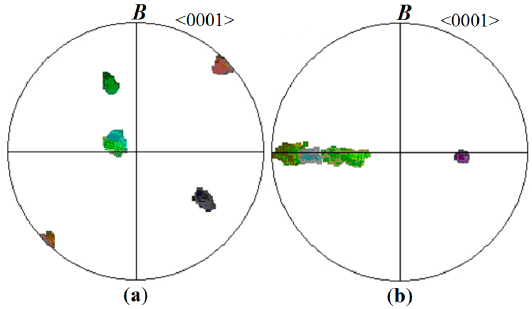
Figure 9. Scattered <0001> pole figures corresponding to the primary zinc-rich crystals in ( a ) Figure 8a and ( b ) in Figure 8b,